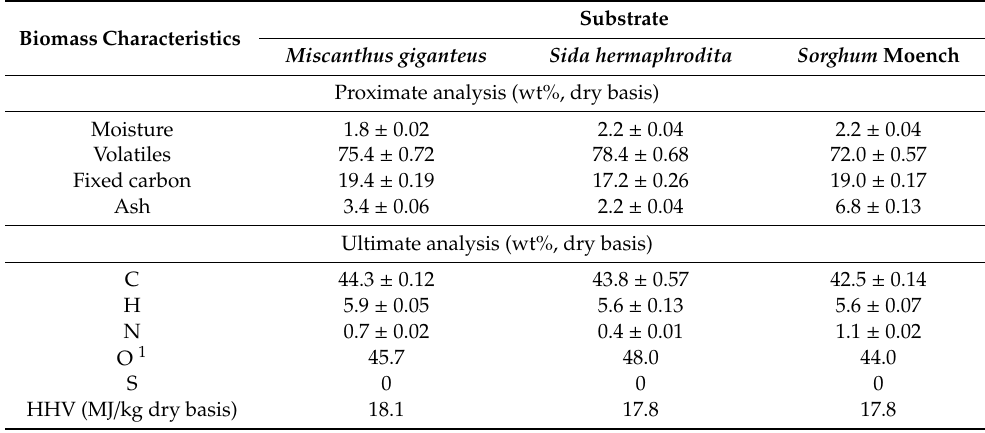
Table 1. Main feedstock characteristics higher heating value